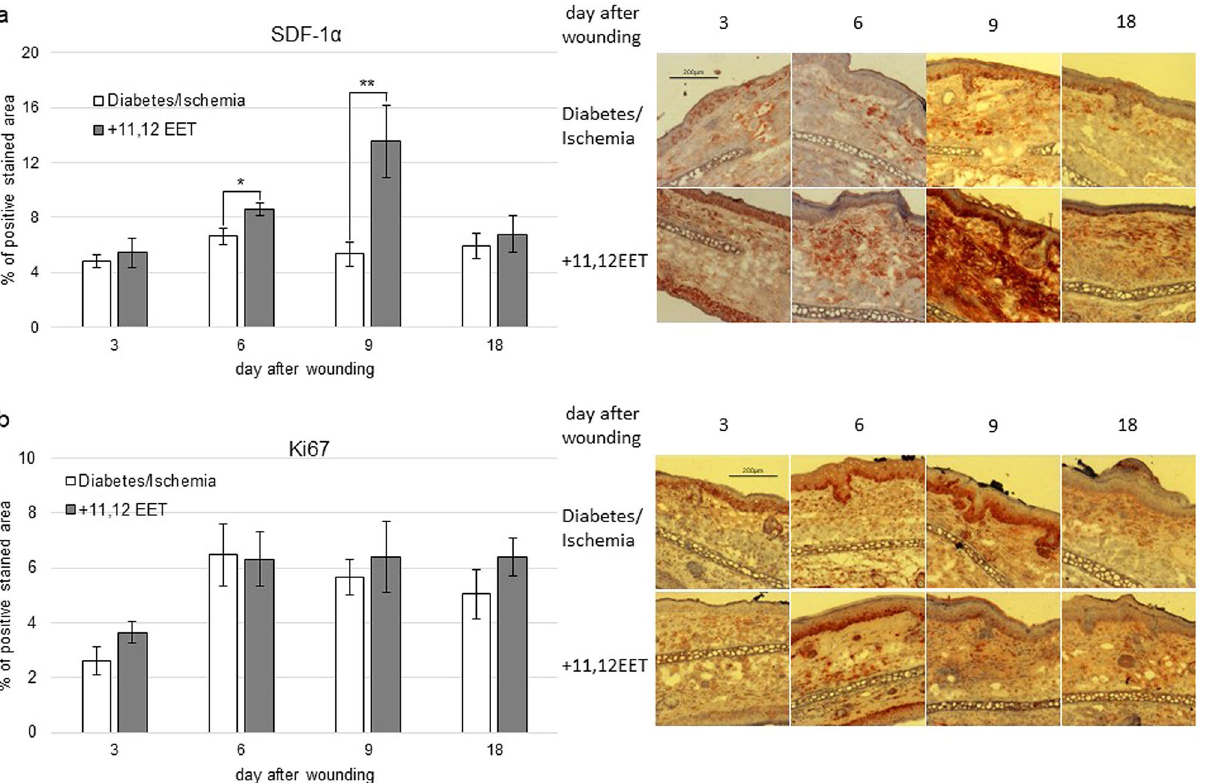
Figure 3. ( a ) Percentage of SDF-1α positive cells on day 3, 6, 9, and 18 of ischemic wounds of diabetic mice with 11,12 EET treatment and solvent control; on the right, representative pictures of the staining ( n = 12 ). ( b ) Percentage of Ki-67 positive area on day 3, 6, 9, and 18 of ischemic wounds of diabetic mice with 11,12 EET treatment and solvent control; on the right, representative pictures of the staining (data is shown as mean ± SD; n = 8 for day 3,6, an 9 n = 10 for day 18). ** p <